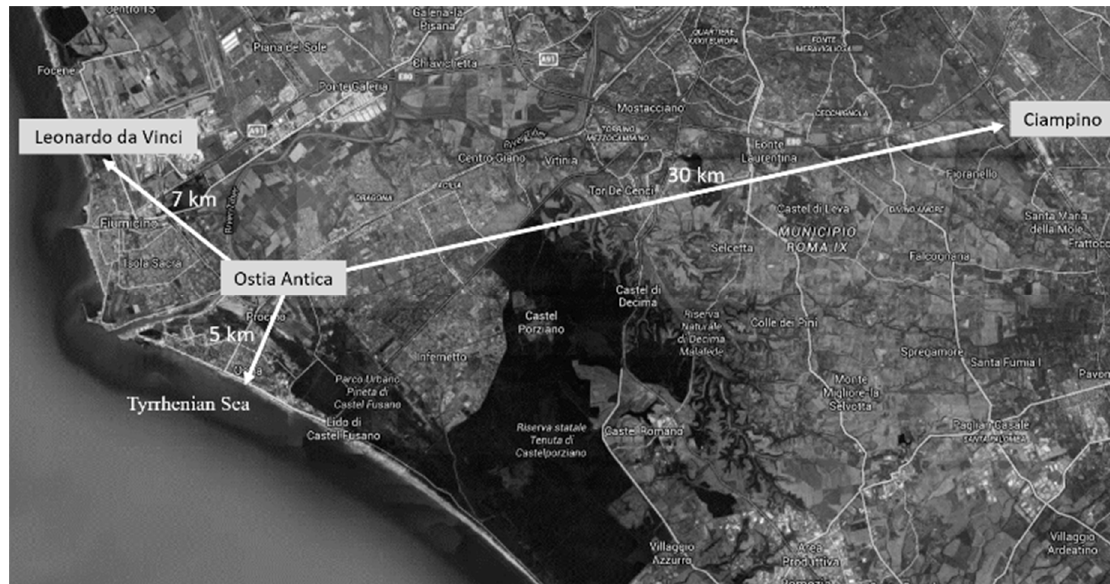
Figure 1. Ostia Antica map which allows one to observe the distances and orientation in relation to the two airports (Leonardo da Vinci on the left and Ciampino on the right) and the Tyrrhenian Sea.